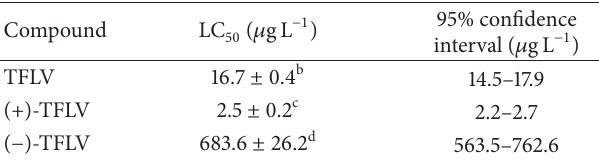
Table 3: LC values of different forms of TFLV at 96 h after 50 exposure to zebrafish a